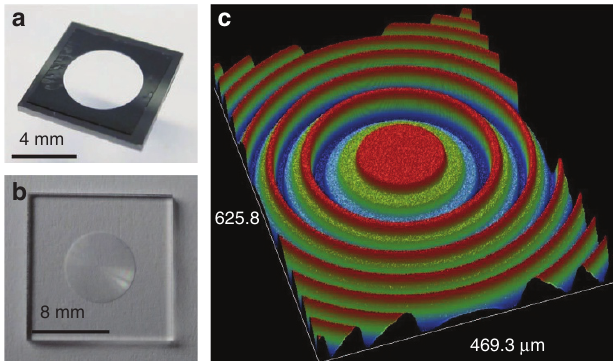
Figure 5 The diffractive and refractive components for the discrete HCL: ( a ) the Si aperture for the refractive lens with the circular aperture etched by DRIE and the polymeric membrane bonded on top; ( b ) the diffractive Fresnel lens fabricated on quartz glass; and ( c ) the center part of the Fresnel lens measured by white light